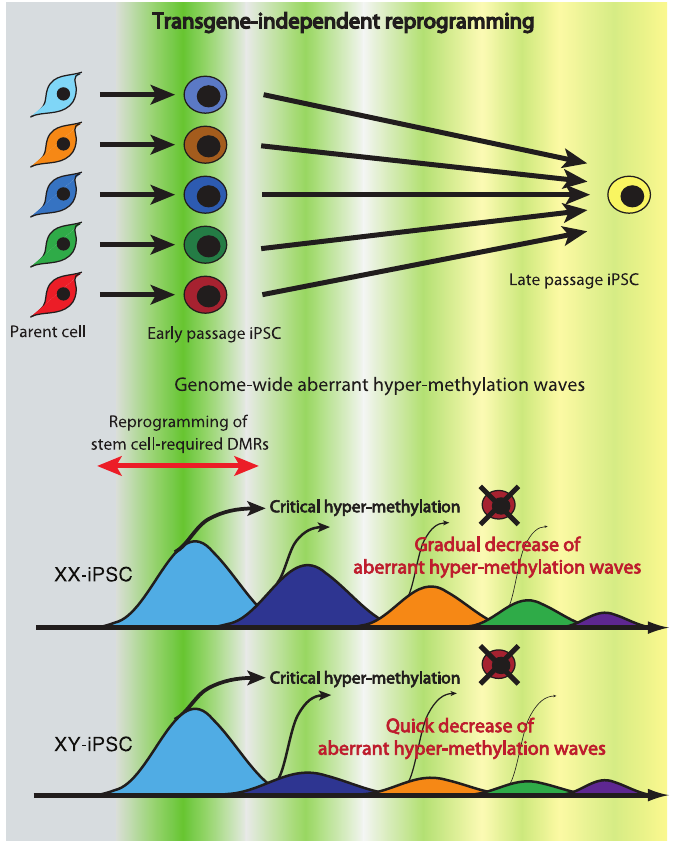
Figure 7. Model of mechanism for transgene-independent reprogramming. During reprogramming from somatic cells to iPSCs, the cells undergo dynamic change of methylation of SS-DMRs and genome. The cells with incomplete reprogramming or excessive hyper-methylation of the genome fail to maintain pluripotency at early passages. Human iPSCs are transgene-independently reprogrammed gradually through ‘‘convergence’’ of periodic aberrant hyper-methylation and become closer to ESCs upon continuous passaging. Due to the sensitivity to aberrant methylation on X chromosome, XY-iPSCs become close to ESCs faster than XX-iPSCs do.